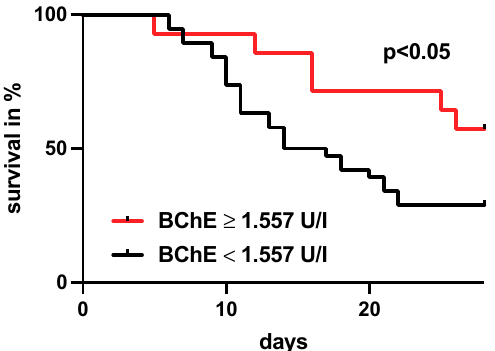
Figure 6. Kaplan–Mayer analysis showing the survival of critically ill COVID-19 patients with BChE activity > 1.557 U/l versus the survival of patients with BChE activity < 1.557 U/l. We demonstrated a survival advantage for BChE activity levels greater than 1.557 U/l measured 24 h after admission (BChE activity > 1.557 U/l in red (n = 14) vs. BChE activity < 1.557 U/l in black (n = 38), survival in days as median: 28 vs. 15, p < 0.05). The survival time analyzes were tested using Kaplan–Mayer curves and the logrank test (Mantel–Cox test).